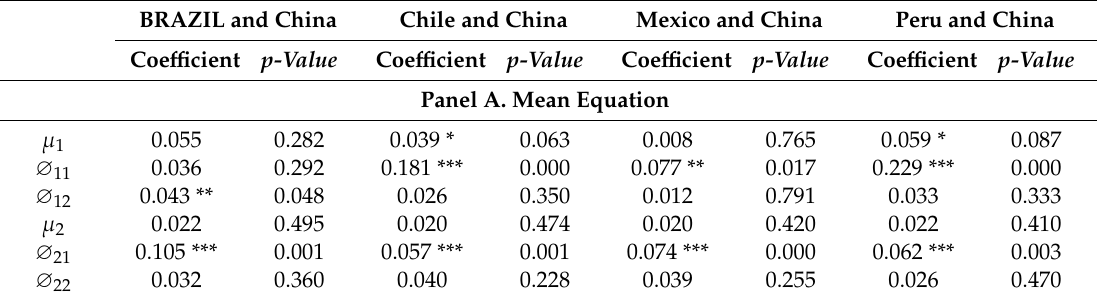
Table 8. Estimates of BEKK-GARCH for the China and Latin American stock markets during the crash of the Chinese stock